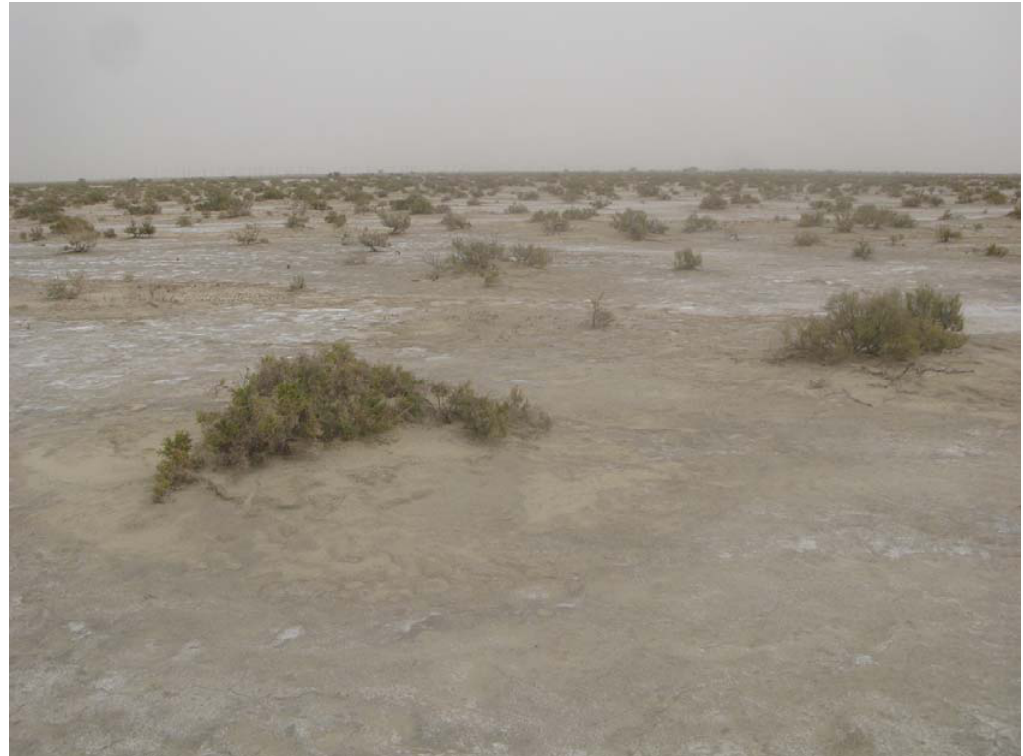
F IGURE 2. Habitat of Stenodactylus affinis on the road from Bandar-e-Abbas to Minab, Hormozgan Province, southern Iran.